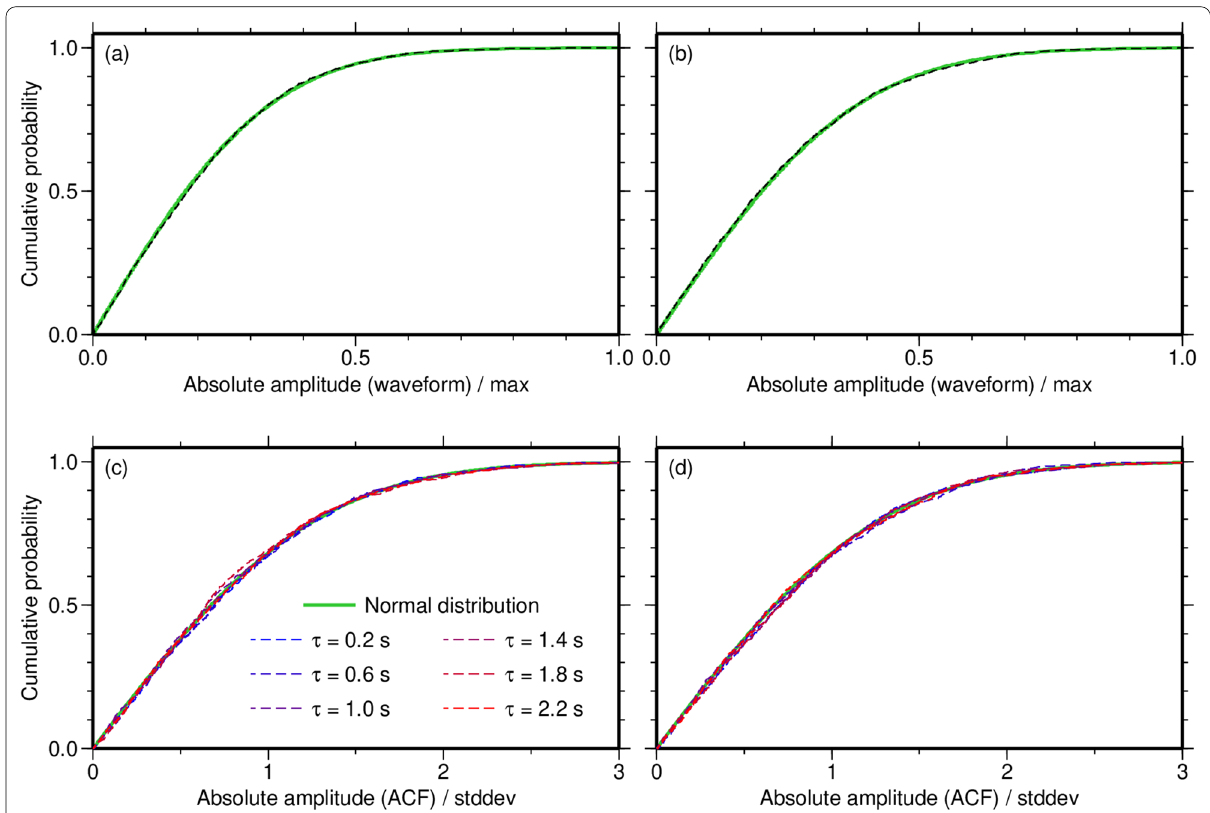
Fig. 5 Evaluating the normal distribution approximation. a , b Cumulative distributions of absolute amplitudes for the observed (whitened) waveform in the noise window (black) and for the normal distribution (green). c , d Cumulative distribution of | ( a eq i , j (τ) − a ave i (τ))/σ a i (τ) | for different values of τ (from blue to red) and for the normal distribution (green). The results for the largest earthquake at Station E.STHM are shown in a and c ; those for the deepest earthquake of the smallest (M2.0) magnitude at Station E.STHM are shown in b and